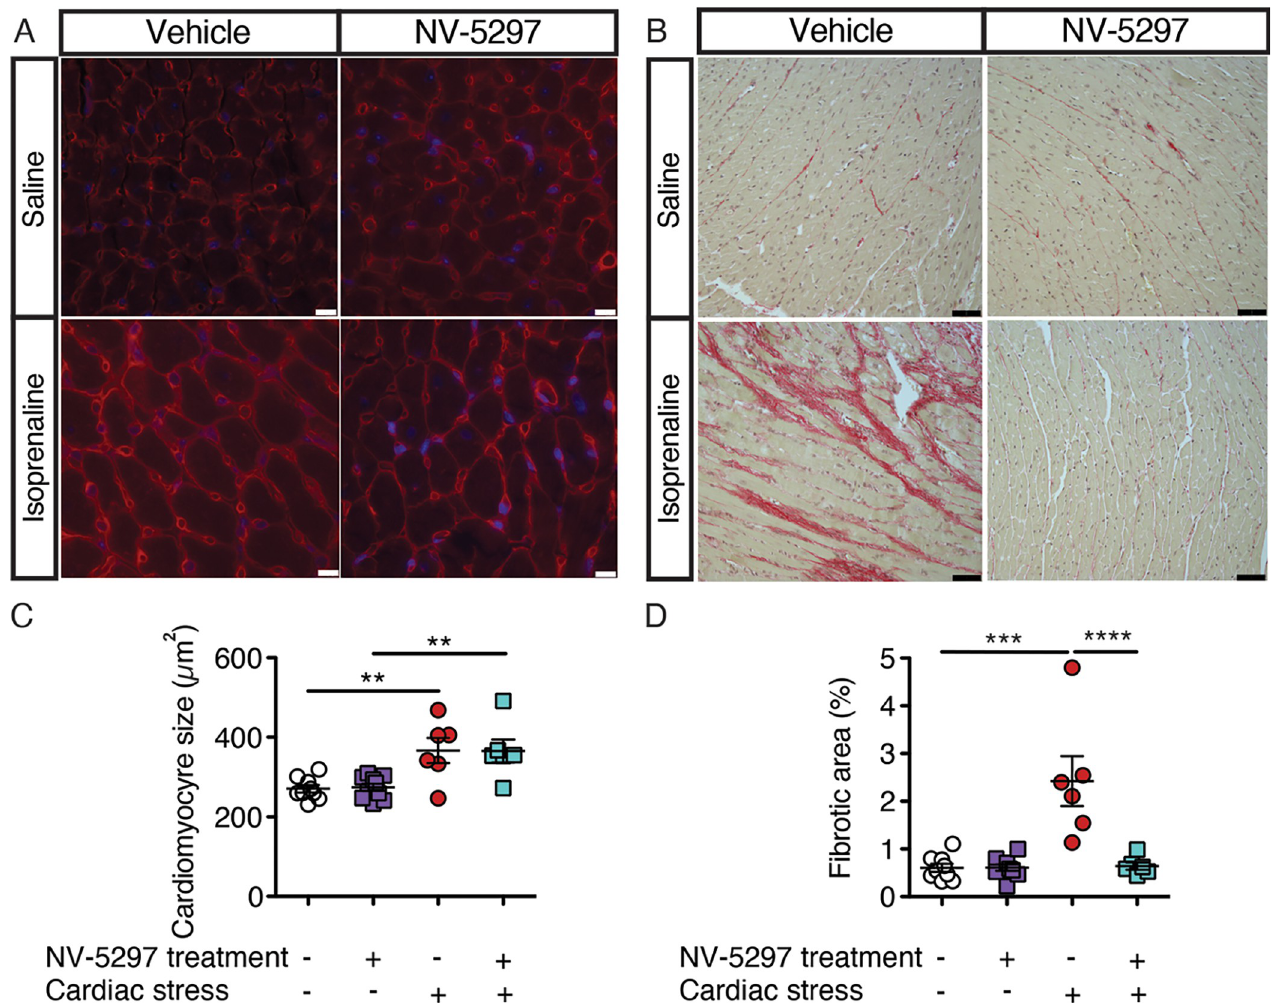
Fig 7. Daily oral dosing of NV-5297 protects against cardiac fibrosis during cardiac hypertrophy following cardiac stress. (A) WGA staining of cardiomyocytes. (B) Picrosirius red staining for collagen fibers. (C) Cardiomyocytes cross-sectional area measurement. Scale bars, 10 μ m. (D) Quantification of collagen staining in the left ventricle of the heart. Scale bars, 50 μ m. (Vehicle-Saline [Veh-Sal] n = 9, NV-5297-Saline [NV-Sal] n = 10, Vehicle-Isoprenaline [Veh-Iso] n = 6, NV-5297-Isoprenaline [NV-Iso] n = 6). Data are presented as mean ± SEM. �� P � 0.01, ��� P � 0.001, ���� P � 0.0001 (Mixed-effect model with Sidak’s multiple comparisons tests).